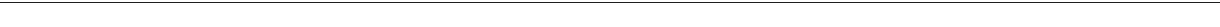
Fig. 6 H2A.Zac-nucleosome dynamics occurs at AR enhancers. a H2A.Zac ChIP-seq average intensity pro fi le using Ngs plots during a time course of DHT treatment, from the control (EtOH), to the following DHT timepoints: 2 h, 4 h and 16 h in LNCaP cells and control (EtOH). The AR sites were split according to the presence of H2A.Zac at AR enhancers; the peaks that overlapped with LNCaP ChromHMM active enhancers were considered as AR enhancers. b NOMe plots representing chromatin accessibility at the AR enhancers with H2A.Zac (LHS) and without H2A.Zac (w/o) (RHS) during the different timepoints of DHT treatment. The dashed lines indicate the maximum accessibility at EtOH (red line) and 16 h (purple line). ** t-test p-value < 0.001. c LHS, IGV screen shots of the androgen-sensitive genes IQGAP2, GREB1 and TRPM8 showing the tracks for H2A.Zac ChIP-seq at EtOH and the different DHT timepoints (red) and AR ChIP-seq (blue) for EtOH and 4 h of DHT treatment. The dashed boxes indicate the AR binding site at the enhancer areas of these genes. RHS, gene expression of these genes across the DHT time course. These data was obtained from Affymetrix Human Gene 2.1 ST expression arrays and it is represented as logarithmic fold chance. *adjusted p- value < 0.05. d LHS, merged IGV tracks of control (EtOH) and DHT timepoints (2 h, 4 h and 16 h) showing H2A.Zac ChIP-seq signal (orange, RPM) overlapped with targeted NOMe-seq average signal, represented as 0 – 1 ratio of each 1-mGpC site (dark blue bars), of two AR enhancer regions for GREB1 and TRPM8 genes. The bottom two tracks correspond to AR ChIP-seq (gray, RPM) to show how the increase of accessibility correlates with AR binding. The diagrams at the RHS represent a magni fi cation at the identi fi ed NDR of each genomic region where the x axis represents each GpC site and the y axis is the average ratio of 1-mGpC of each GpC site, in the DHT